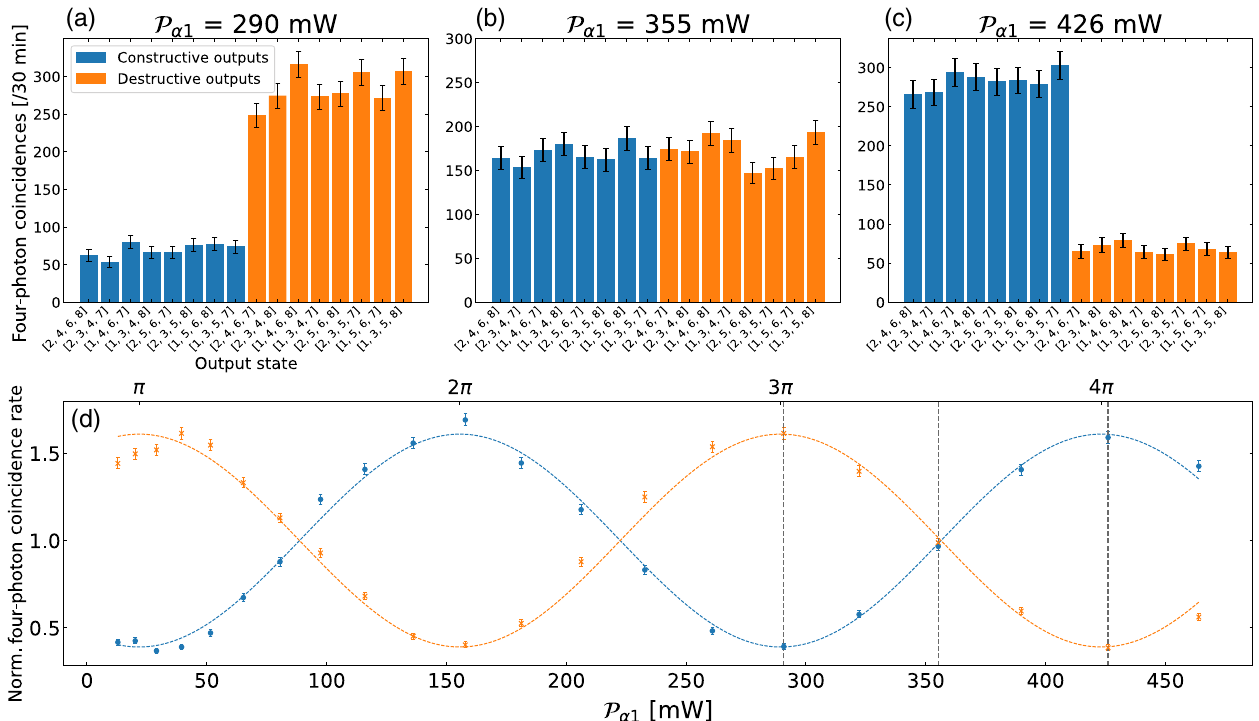
FIG. 3. (a) – (c) Number of detected coincidences in 30 min for the 16 four-photon output states for a given electrical power P α applied to the internal phase shifter of the integrated interferometer. We observe a clear shift from (a) destructive interference at P α ¼ 290 mW ( α 1 ∼ 3 π ) to (c) constructive interference at P α ¼ 426 mW ( α 1 ∼ 4 π ). The error bars indicate the shot-noise error of coincidences N . (d) The total normalized four-photon coincidence rate (sum of all eight output states) for the constructive and destructive outputs, as a function of P α 1 or the phase α